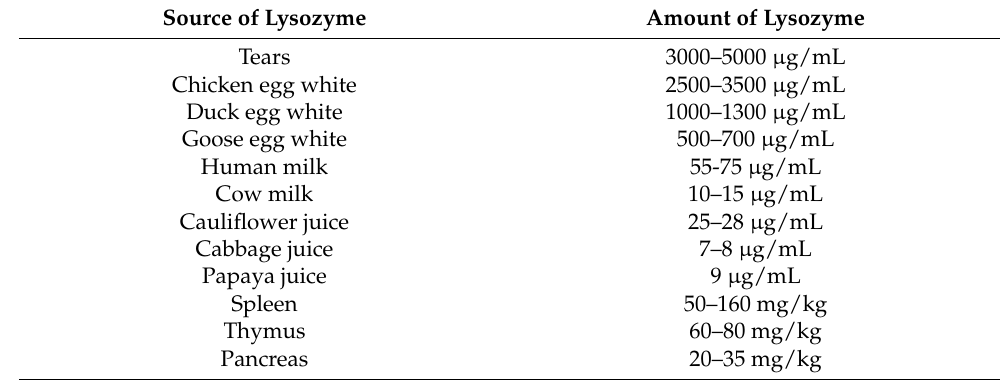
Table 1. Selected sources of